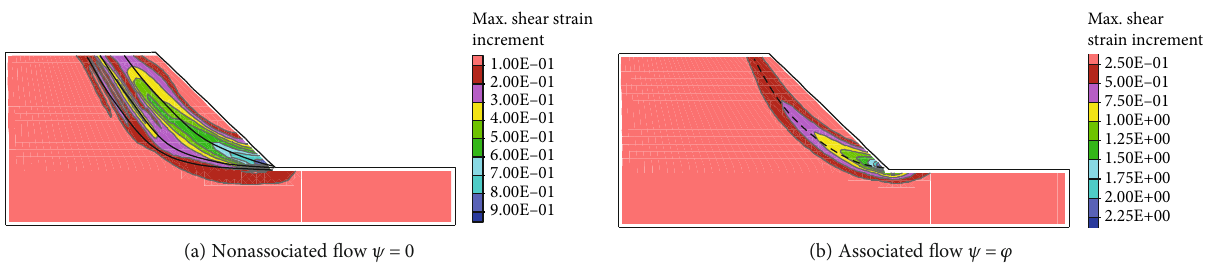
Figure 2: Maximum shear strain counters obtained by TSST b = 1 : 0 when the water level drops to L / H = 1 : 0 .